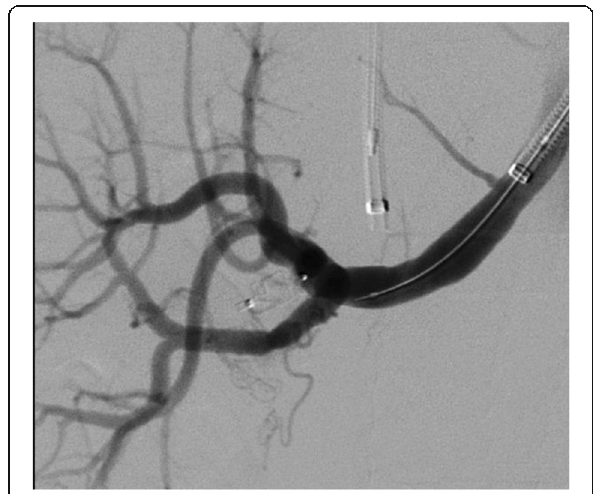
Fig. 3 Control angiography showing the good procedural